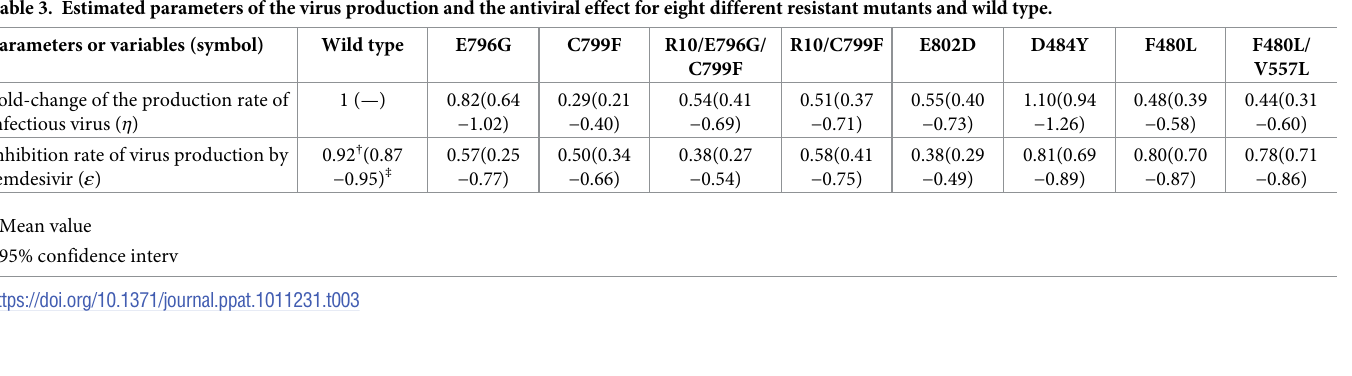
Table 3. Estimated parameters of the virus production and the antiviral effect for eight different resistant mutants and wild type. Parameters or variables (symbol)